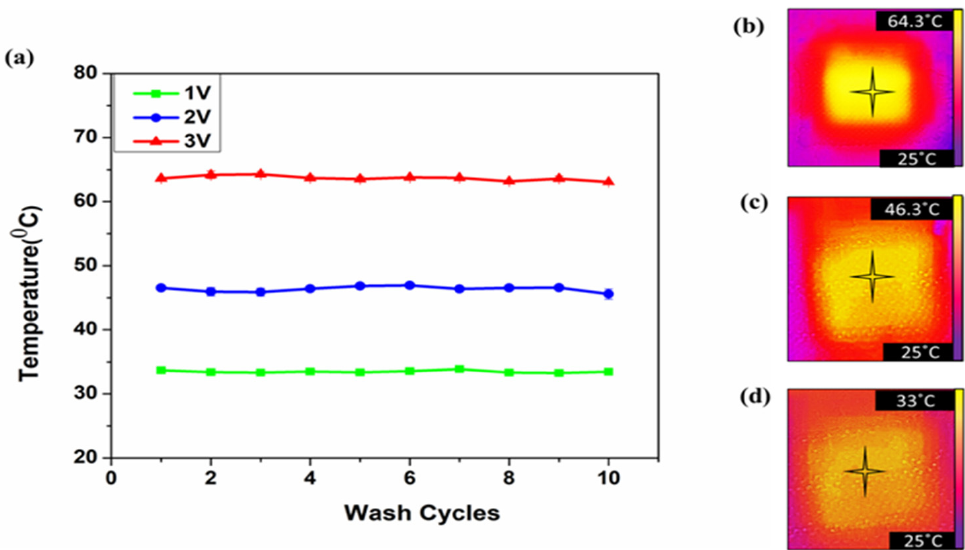
Figure 9. Temperature change ( a ) after 10 washing cycles using voltage values of 1 V, 2 V, and 3 V, ( b – d ) thermal image after washing.